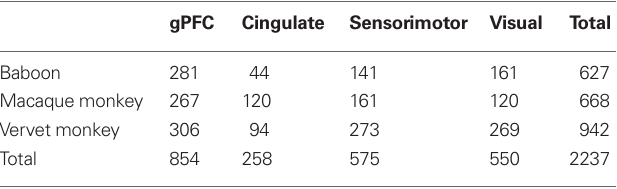
Table 13 | Number of layer iii pyramidal cells included for study in the granular prefrontal (gPFC), cingulate, sensorimotor, and visual cortex of the animals studied